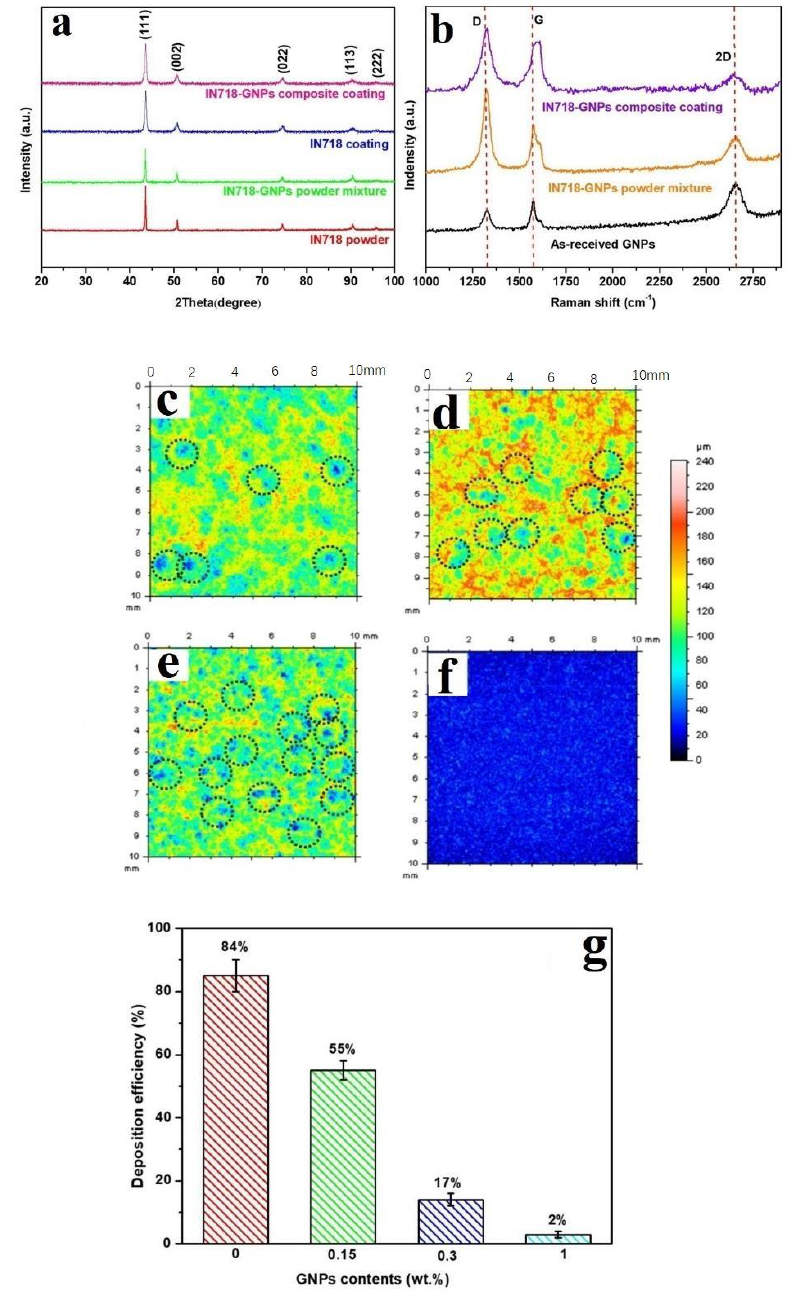
Figure 3. ( a ) XRD patterns and ( b ) Raman spectra of the raw materials and the milled and sprayed IN718 GNP composites, surface topologies of CS coatings with different GNP loadings (in wt%): ( c ) 0%, ( d ) 0.15%, ( e ) 0.3%, ( f ) 1%. ( g ) DE of the IN718/GNP composite coatings. Presented with permission from [53].